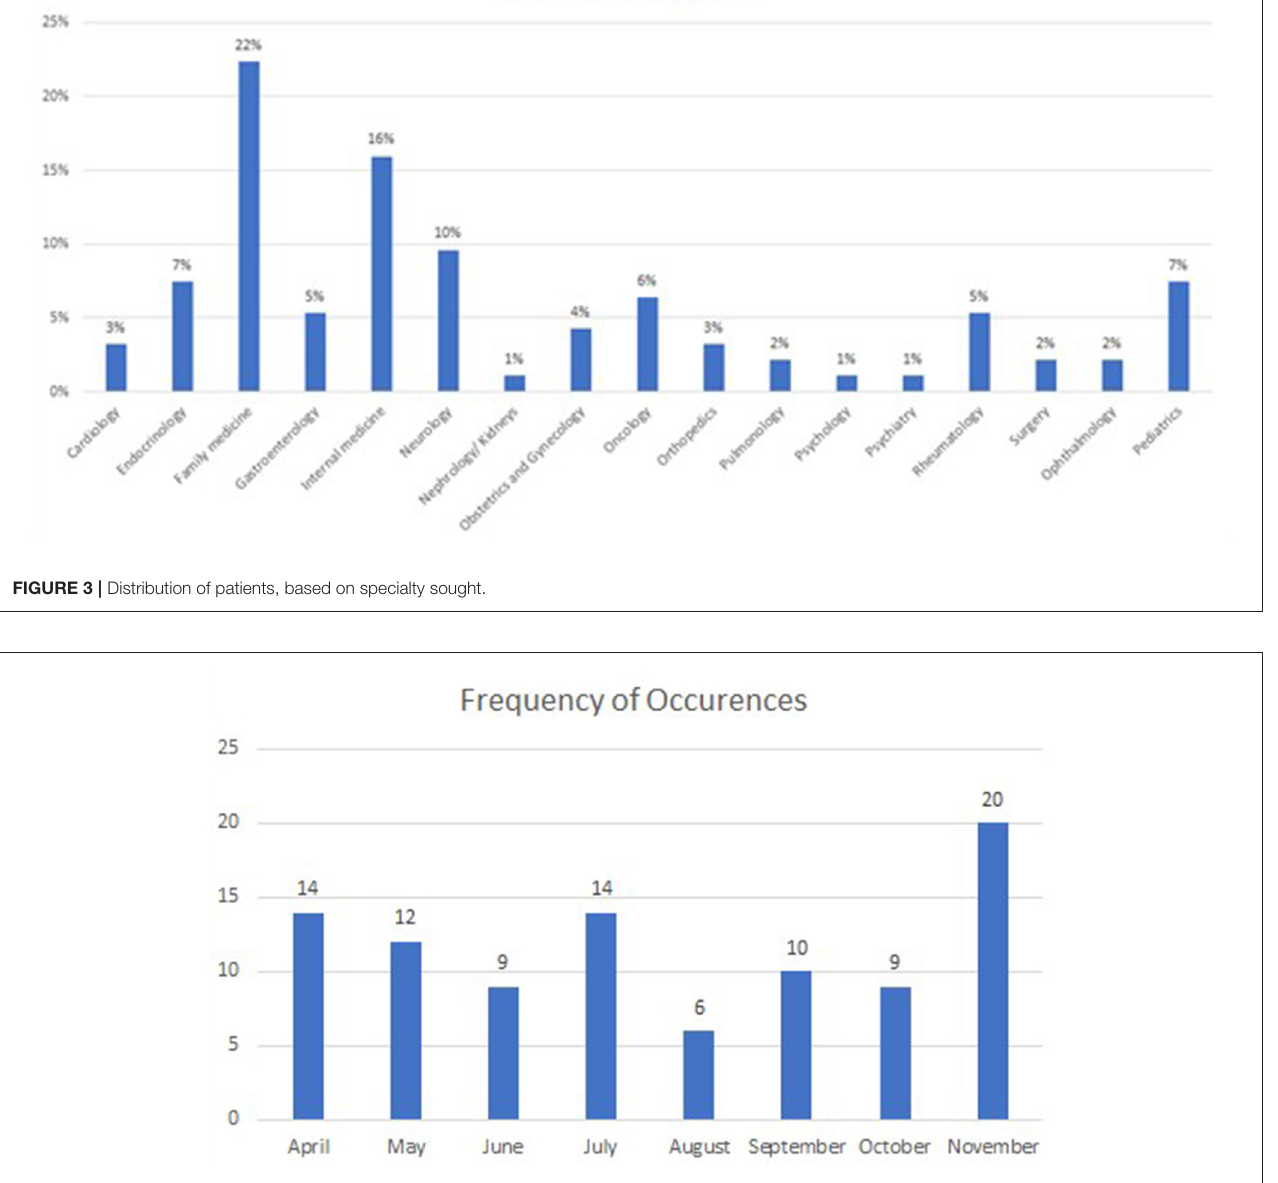
FIGURE 4 | Distribution of patients, based on month of